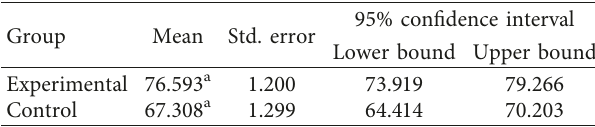
Table 10: Estimated marginal